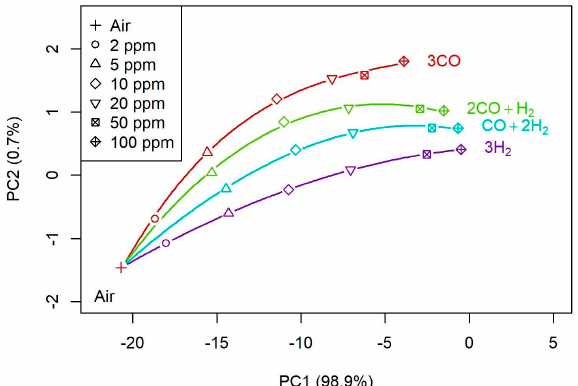
Figure 2. Results of PC analysis of the measurement of 575 virtual sensors. Gas mixtures with the same total concentration and different ratio of CO and H 2 (noted in the